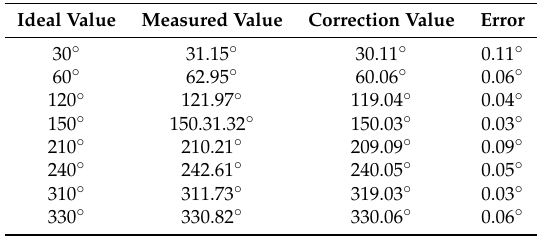
Table 1. Experimental results obtained when the REMC method is employed in the experiment under a non-ideal camera